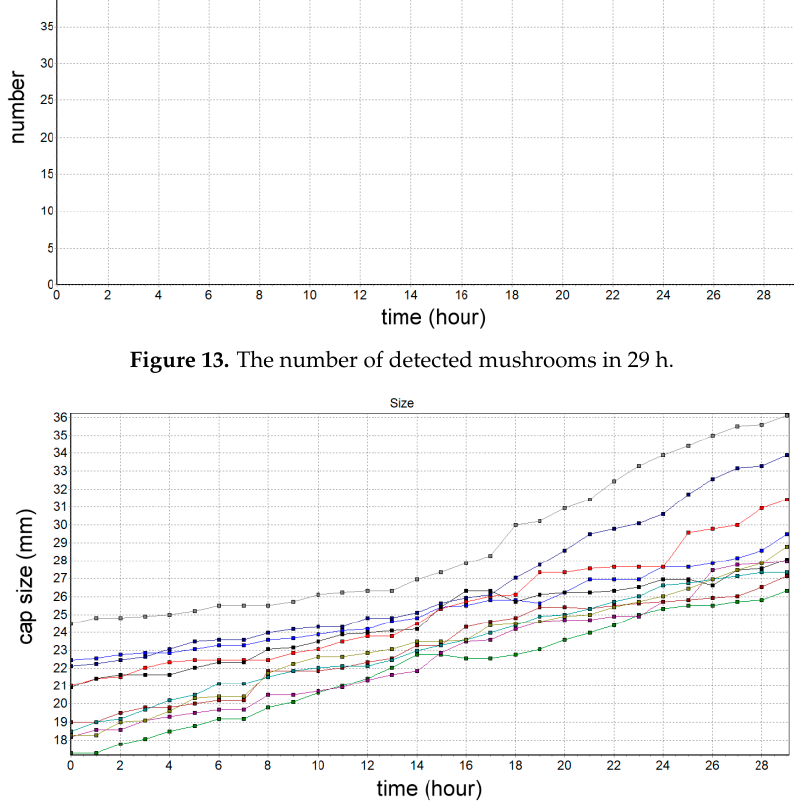
Figure 14. The sizes of 10 randomly selected mushrooms.